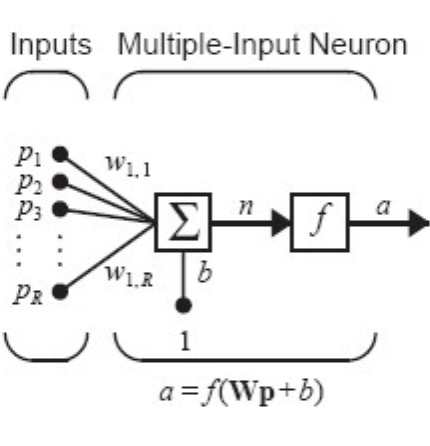
Figure 4 . A multiple input